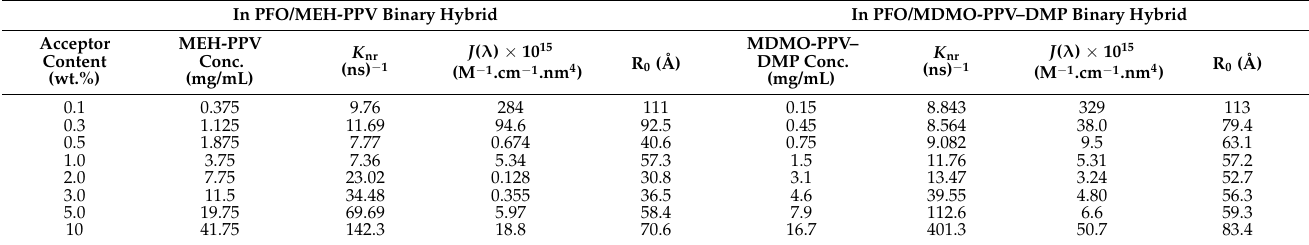
Table 1. Parameters of energy transfer from PFO to both MEH-PPV and MDMO-PPV–DMP. In PFO/MEH-PPV Binary Hybrid In PFO/MDMO-PPV–DMP Binary Hybrid Acceptor MEH-PPV Content (wt.%)